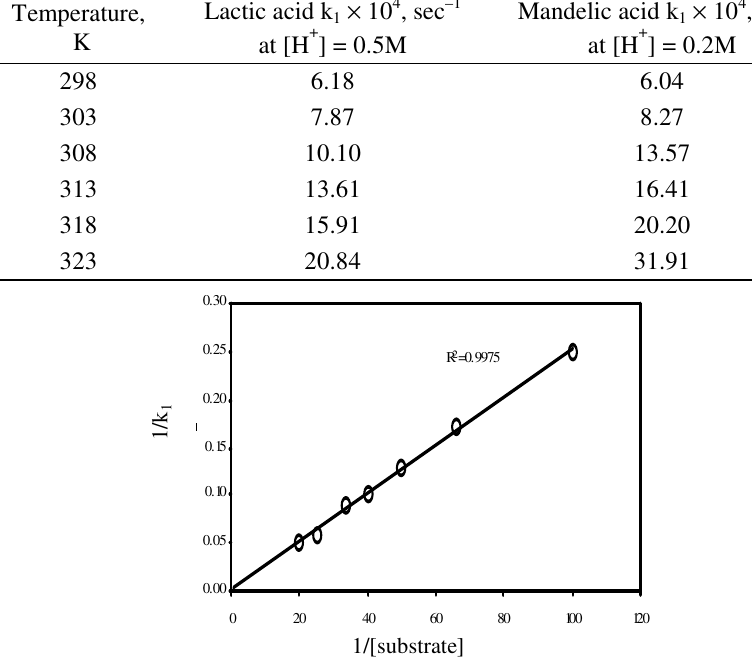
Figure 1. Variation of rate with substrate concentration.